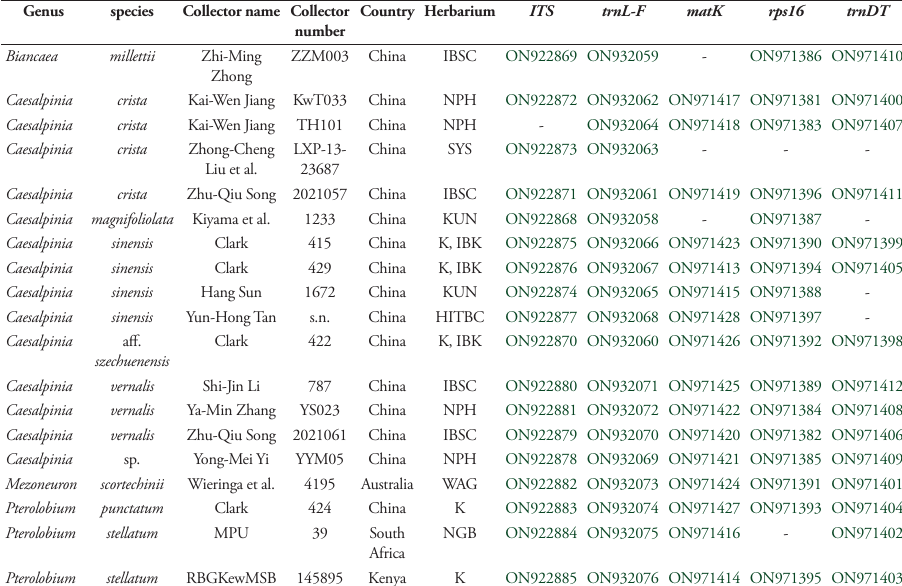
Table 1. Accessions sequenced and used to generate the molecular based phylogeny, with GenBank